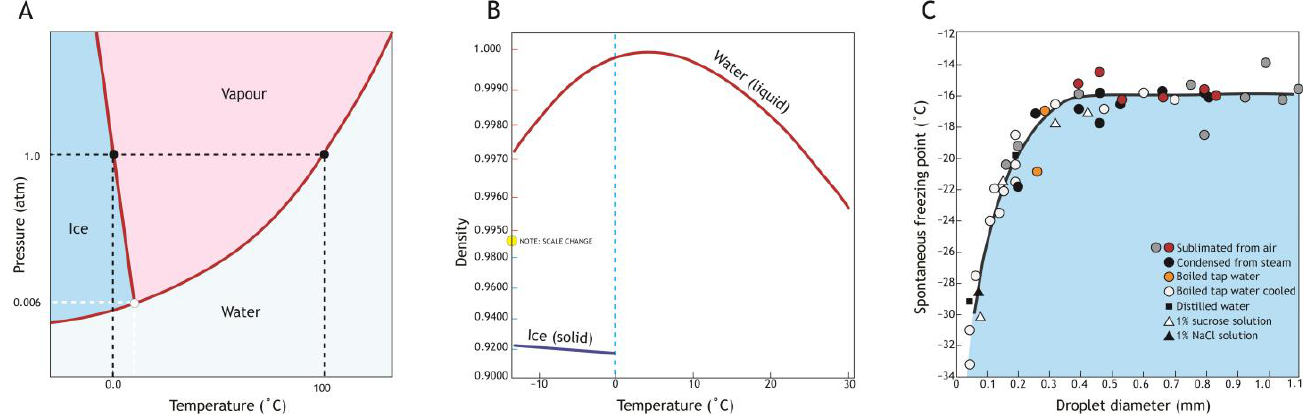
Figure 1. The metric temperature scale introduced by Anders Celsius is based on prominent phase changes of water; freezing at 0 °C and boiling at 100 °C at 1 atmosphere pressure. ( A ) Water phase changes, solid from vapour, vapour from liquid, and liquid from solid, reflect temperature and pressure. These meet at a single point called the triple point, where all three phases can coexist. ( B ) However, supercooling of water occurs when temperature reduction below 0 °C is not accompanied by crystallization. In biological systems the formation of ice decreases the density by nearly ~9%, leading to an increase in volume of the crystalline structure (ice) that can disrupt tissues. Density changes are illustrated over the ~40 °C range likely to be experienced by New Zealand alpine insects. ( C ) Droplet size influences the temperature at which water phase change occurs (liquid to ice) as demonstrated by Heverly (1949) [14] who cooled water droplets of different sizes to measure their temperature of crystallization, and noted that at this scale the purity of the water used had little effect (colours indicates origin of water).